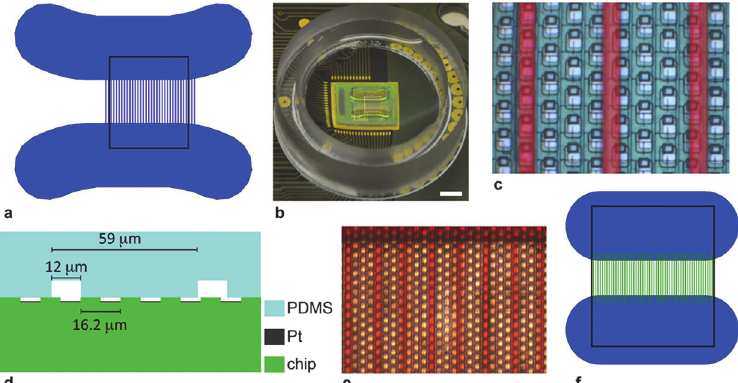
Fig 1. Geometry and layout of poly(dimethylsiloxane) axonal channel device on microelectrode array chip (a) Drawing of axonal channel device, with 12 μ m channels, and neuronal culture chambers; rectangle shows dimensions of electrode array, which is 1.75 x 2.0 mm 2 . (b) Photograph of packaged chip wire-bonded to a printed circuit board and with channel device on top, scale bar is 2 mm, the plastic ring is 18 mm in diameter and used to hold cell medium. (c) Zoom in on electrodes and channels: channels are lighter and highlighted in red; scale bar is 10 μ m. (d) Cross section of chip, electrodes and channel device on top showing characteristic dimensions and corresponding to c. (e) Photograph of channel region of device; channels were filled with red food coloring to illustrate tightness of bonding to chip surface; scale bar is 20 μ m. (f) Smaller chambers and channels used for some experiments. Channels were 2 – 8 μ m in width; black box corresponds to array, which is 1.7 x 2.0 mm 2